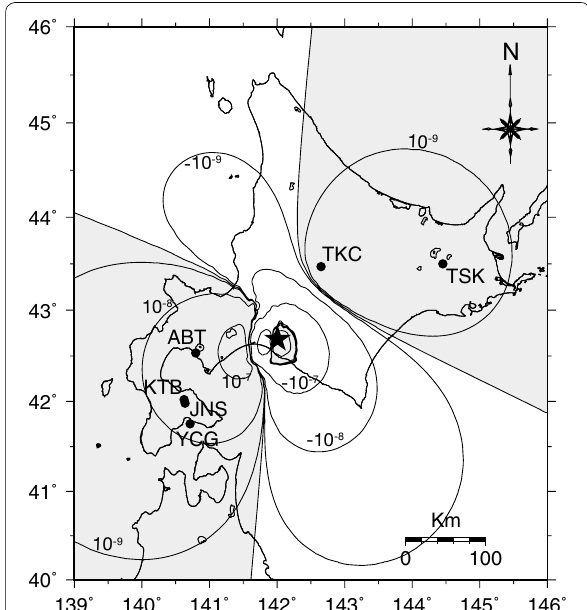
Fig. 1 Locations of the monitored observation wells (ABT, JNS, KTB, TKC, TSK, and YCG; solid circles) and the epicenter of the 2018 Hokkaido Eastern Iburi earthquake (solid star). Volumetric strain, indicated by contours extending from the epicenter, was calculated using the fault model of the earthquake (Geospatial Information Authority of Japan 2018). The gray area indicates tensile